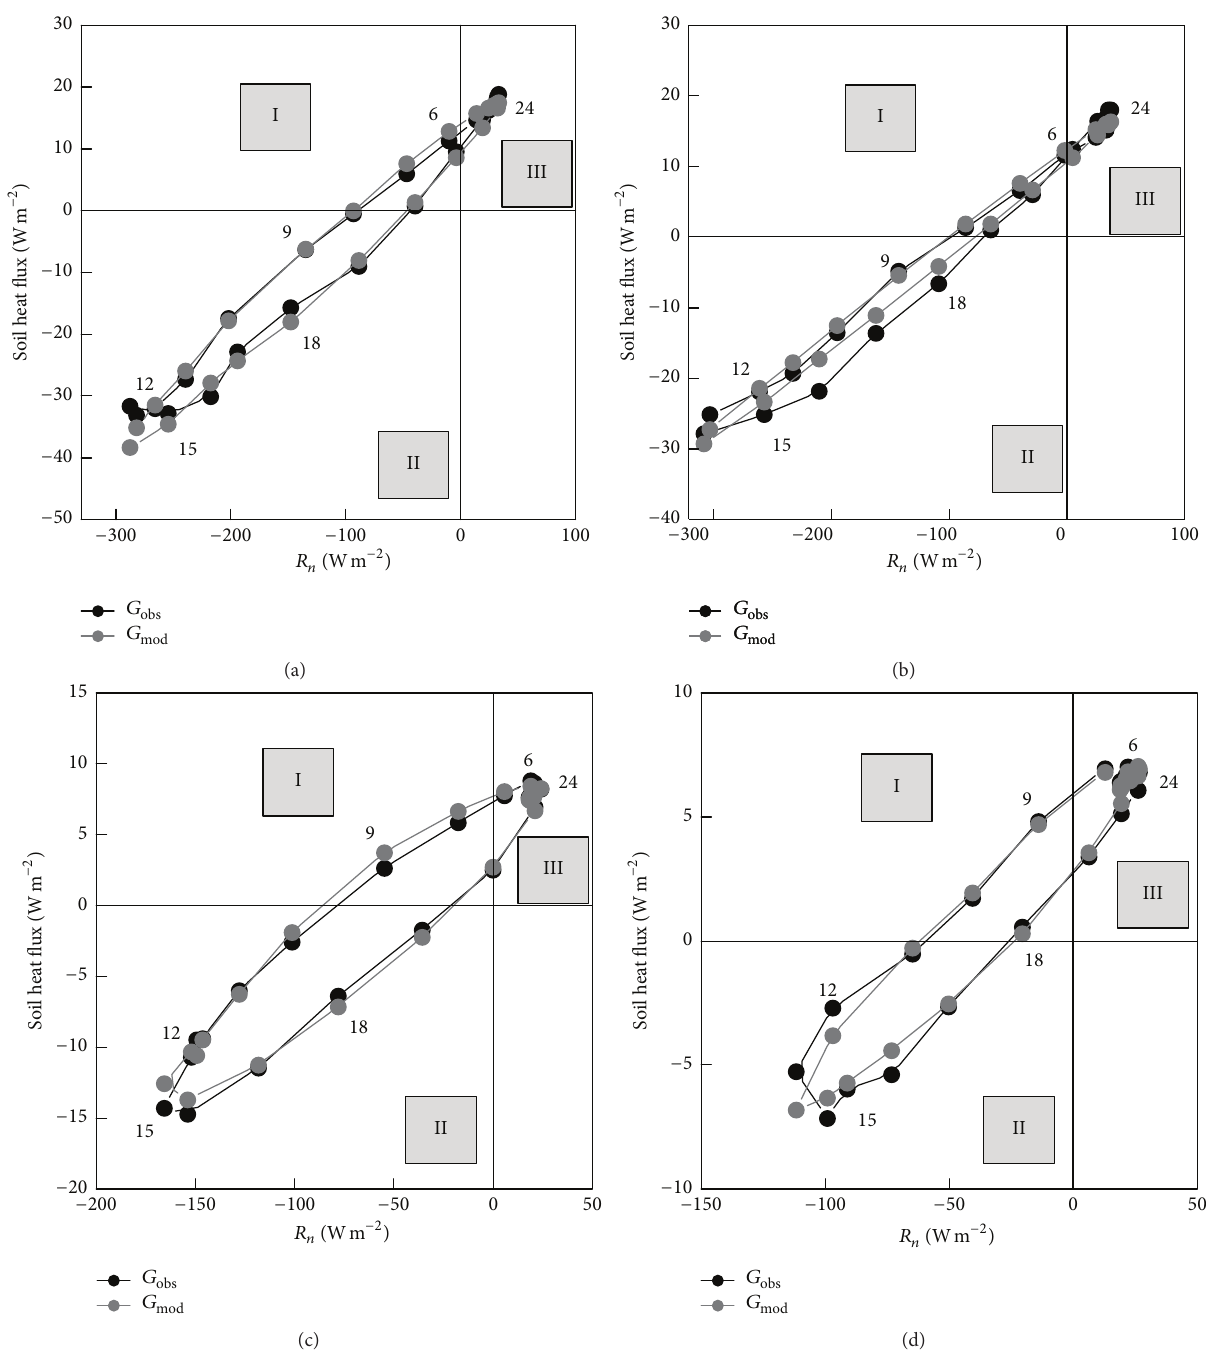
Figure 7: Hysteresis loop relations between observed (obs, black colour) and modelled (mod, grey colour) soil heat flux ( 𝐺 ) and net radiation ( 𝑅 𝑛 ) in the EACF: (a) December 2013, (b) January 2014, (c) February 2014, and (d) March 2014. The numbers represent the local time (hour). I, II, and III indicate the period of the day: transitional, daytime, and night-time periods,